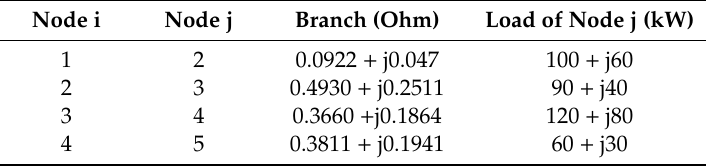
Table A1. Data for the IEEE 33-bus radial distribution system